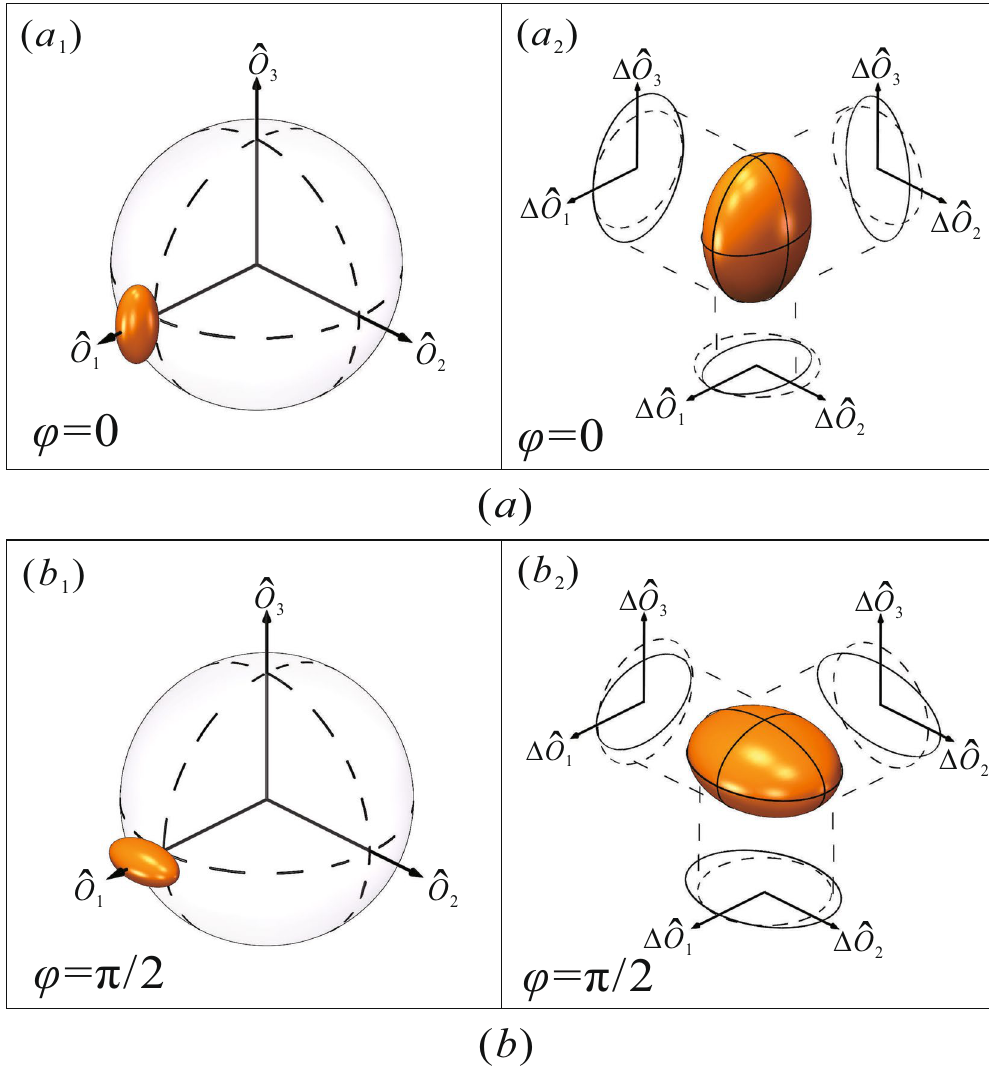
Figure 7. OAM squeezed states mapped onto the orbital Poincaré sphere. ( a ) orbital Poincaré sphere for ϕ = 0. ( b ) orbital Poincaré sphere for ϕ = π